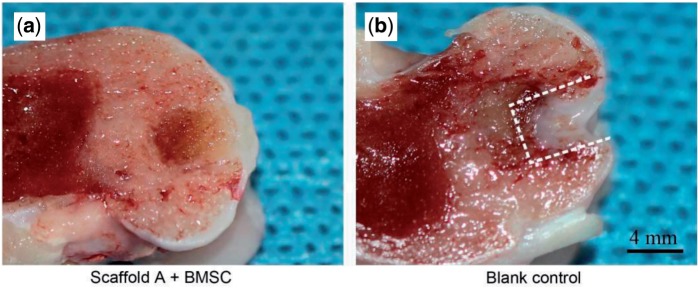
Cross-section views of the regenerative osteochondral tissue repaired by scaffolds A with external BMSCs (a) and the blank control (b). The dashed lines indicate the border between the neo-tissue and the native cartilage.